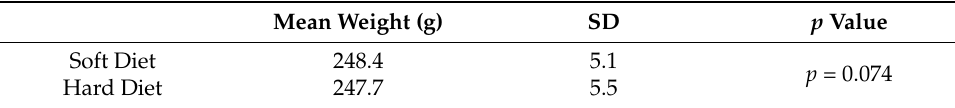
Table 3. Weight measurement